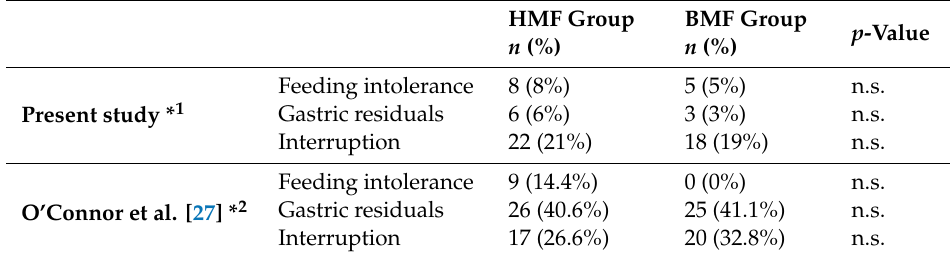
Table 5. Feeding tolerance at fortifier introduction: comparison of data from the present study with the